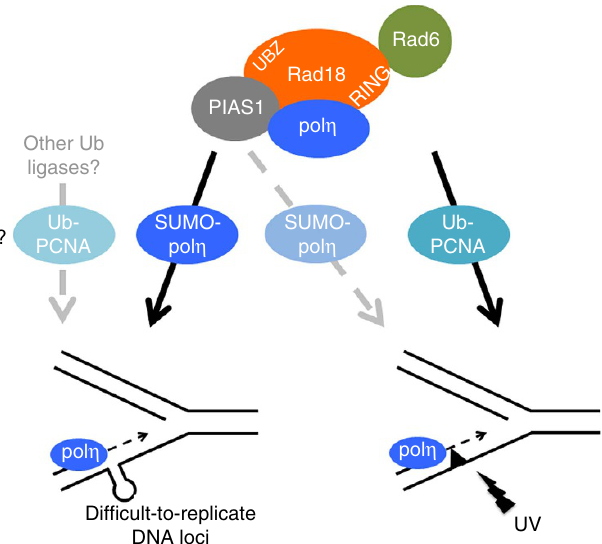
Figure 10 | A model for the dual regulation of human pol g in response to ultraviolet-C lesions and at difficult to replicate DNA loci. During unperturbed S phase or after a low dose of APH, SUMOylation of pol Z on K163 promotes its recruitment to replication forks to allow the timely completion of the replication of specific genomic regions presumably bearing non-B DNA structures. This PTM relies on the ternary complex formed by pol Z , Rad18 and the SUMO ligase PIAS1 and is independent of Rad18 ubiquitin ligase activity. Whether pol Z function at difficult to replicate DNA sequences also requires Rad18-independent PCNA ubiquitination remains to be established. After ultraviolet exposure, PCNA is ubiquitinated at forks stalled by photoproducts by the Rad18/Rad6 complex, which allows accumulation of pol Z at damaged sites, as already described. However, SUMOylation of pol Z on K163 may also contribute, to a minor extent, to the recruitment of the polymerase, constituting an alternative pathway in cells deficient in PCNA